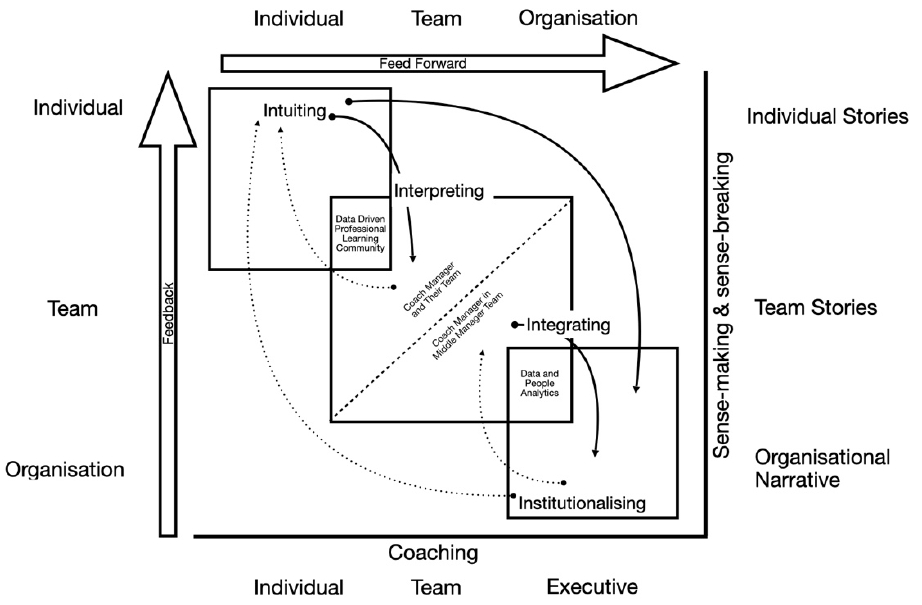
Figure 1. The amended 4Is model (Percy and Dow